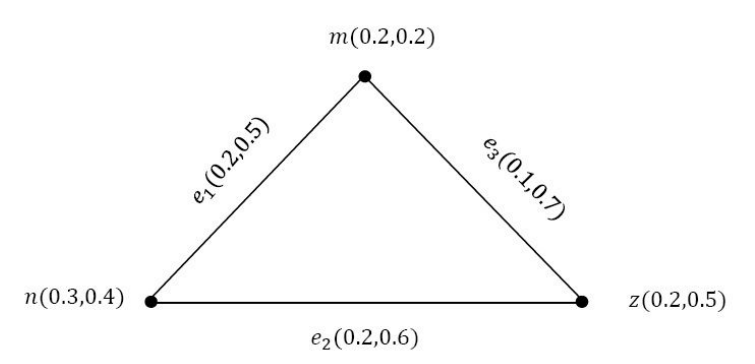
Figure 2. VG ζ with two strong edges.